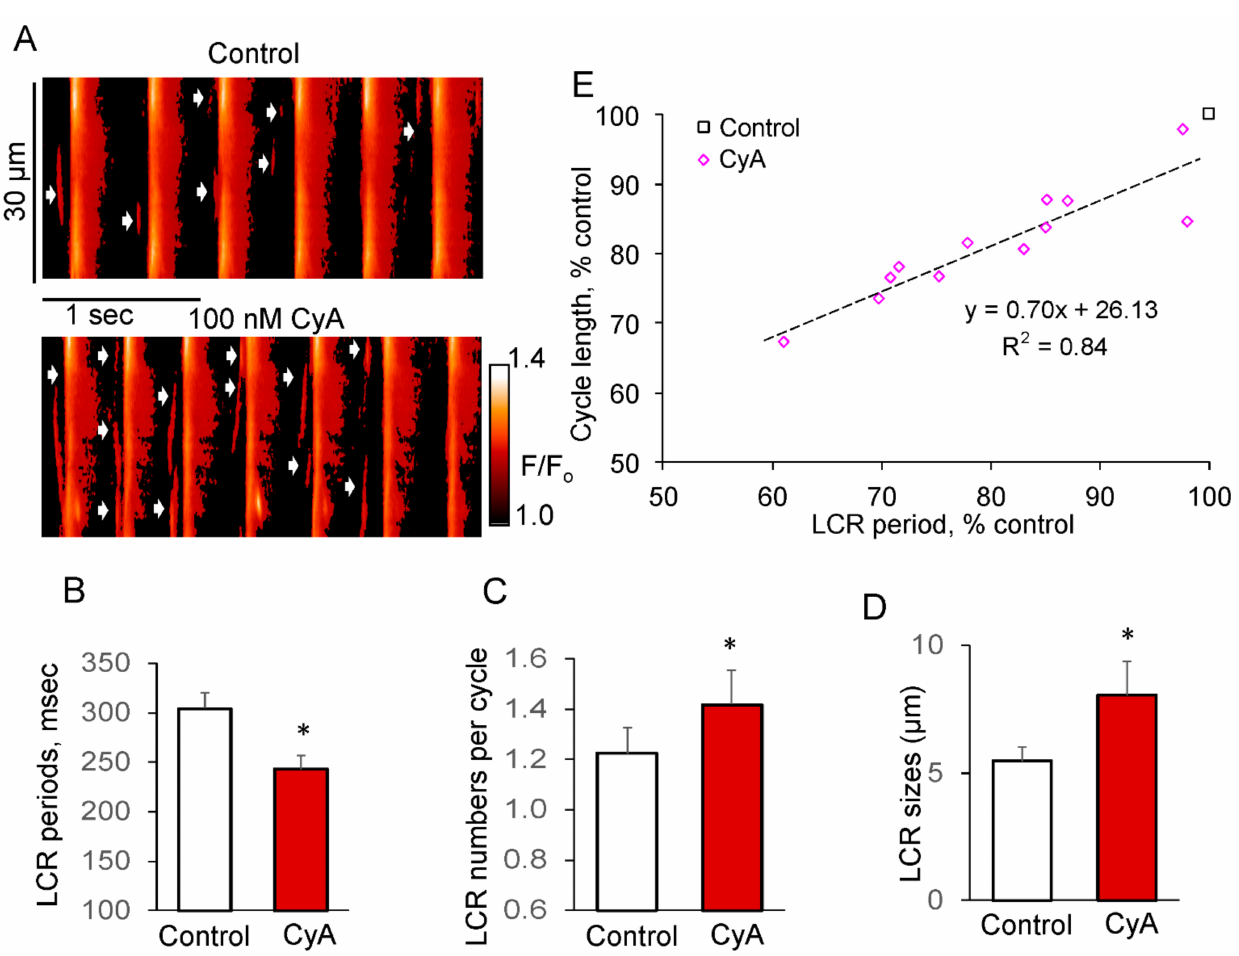
Figure 7. PP inhibition by CyA increases the LCR number and size of LCRs in SANC during spontaneous AP firing. ( A ) Confocal line-scan image of a representative SANC prior to and during exposure to 100 nmol/L CyA; CyA-induced changes in: ( B ) LCR period; ( C ) LCR number per cycle; ( D ) LCR size ( n = 12). ( E ) PP inhibition-induced changes in the LCR periods predict the concurrent changes in the AP cycle lengths ( n = 12). * p < 0.05 vs.